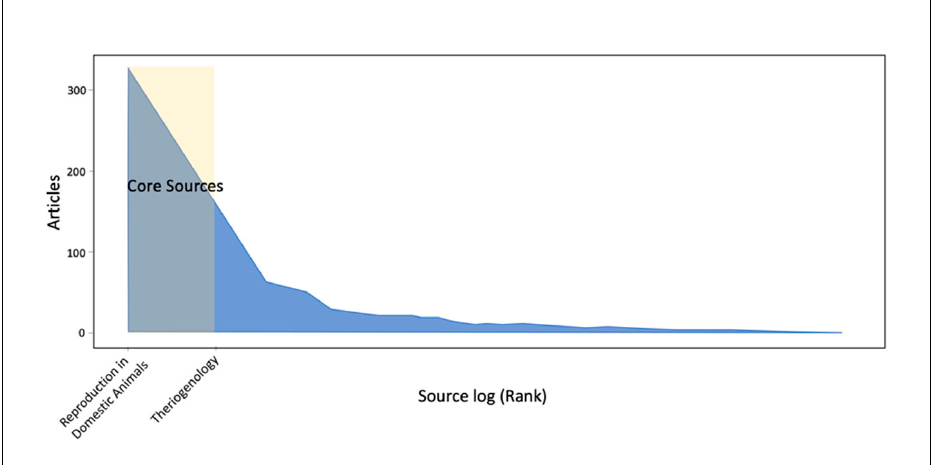
Figure 2. Bradford’s Law plot indicating the core sources of the literature in the field of small animal reproduction. Field-oriented journals (Reproduction in Domestic Animals and Theriogenology) account for most of the literature on small animal reproduction in the last decade. Table 2. The top twenty of most prolific journals publishing papers in the field of small animal reproduction.